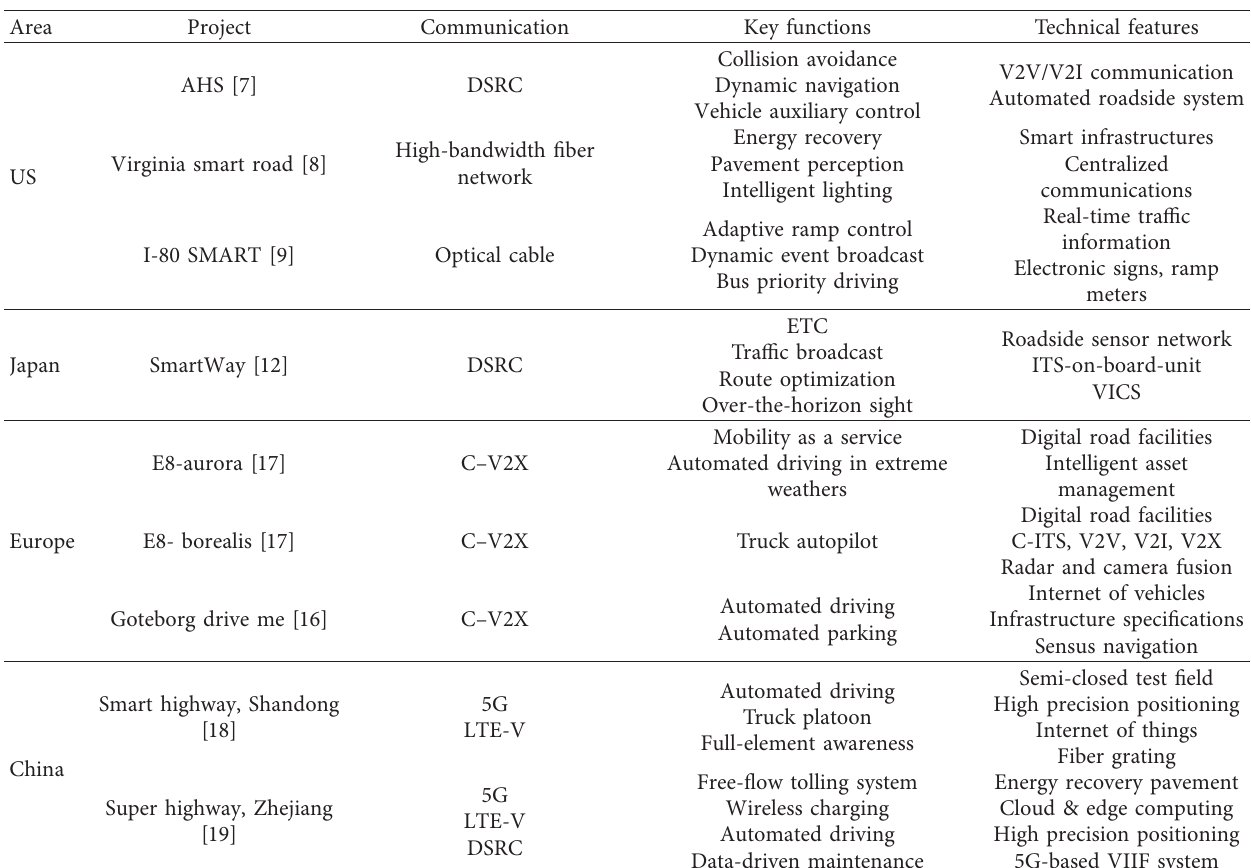
Table 1: Typical smart highway projects and technical features.